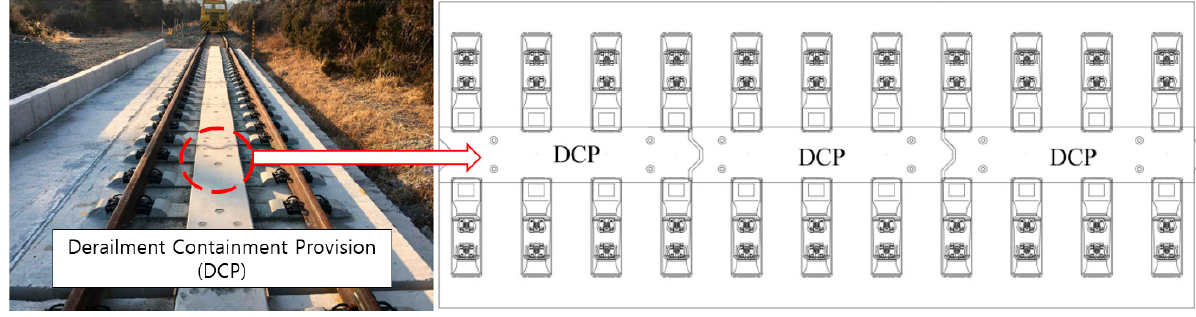
Figure 4. DCP installation example of Type 1.